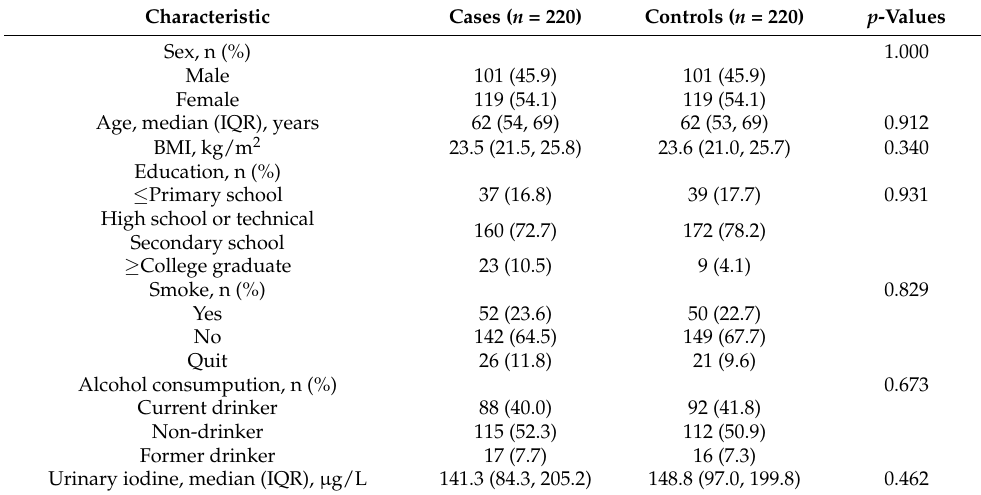
Table 1. Characteristics of thyroid nodule and corresponding health controls ( n = 440).